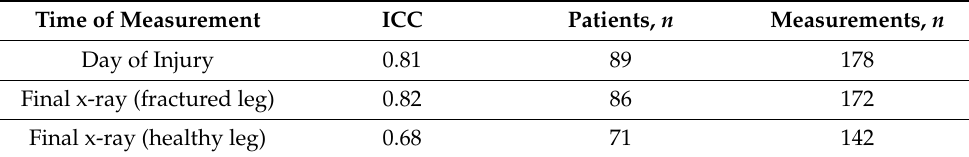
Table 5. Factors associated with lack of remodeling at one year (anterior tilt angle >0° at the final exam) after a trampoline fracture of the tibia. Table 6. Inter-rater agreement between the two radiologists that evaluated radiographs of trampoline fractures of the tibia based on intraclass coefficient (ICC). Only the tilt angle values of patients measured independently by both radiologists were